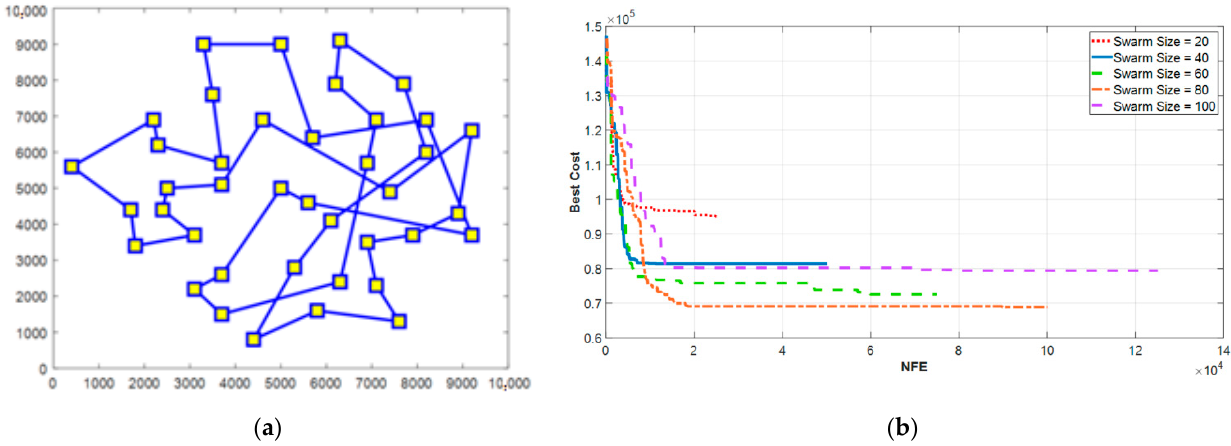
Figure 19. ( a ) The optimal flight path calculated by the PSO algorithm and ( b ) the performance of the PSO algorithm under different sizes of the swarm.